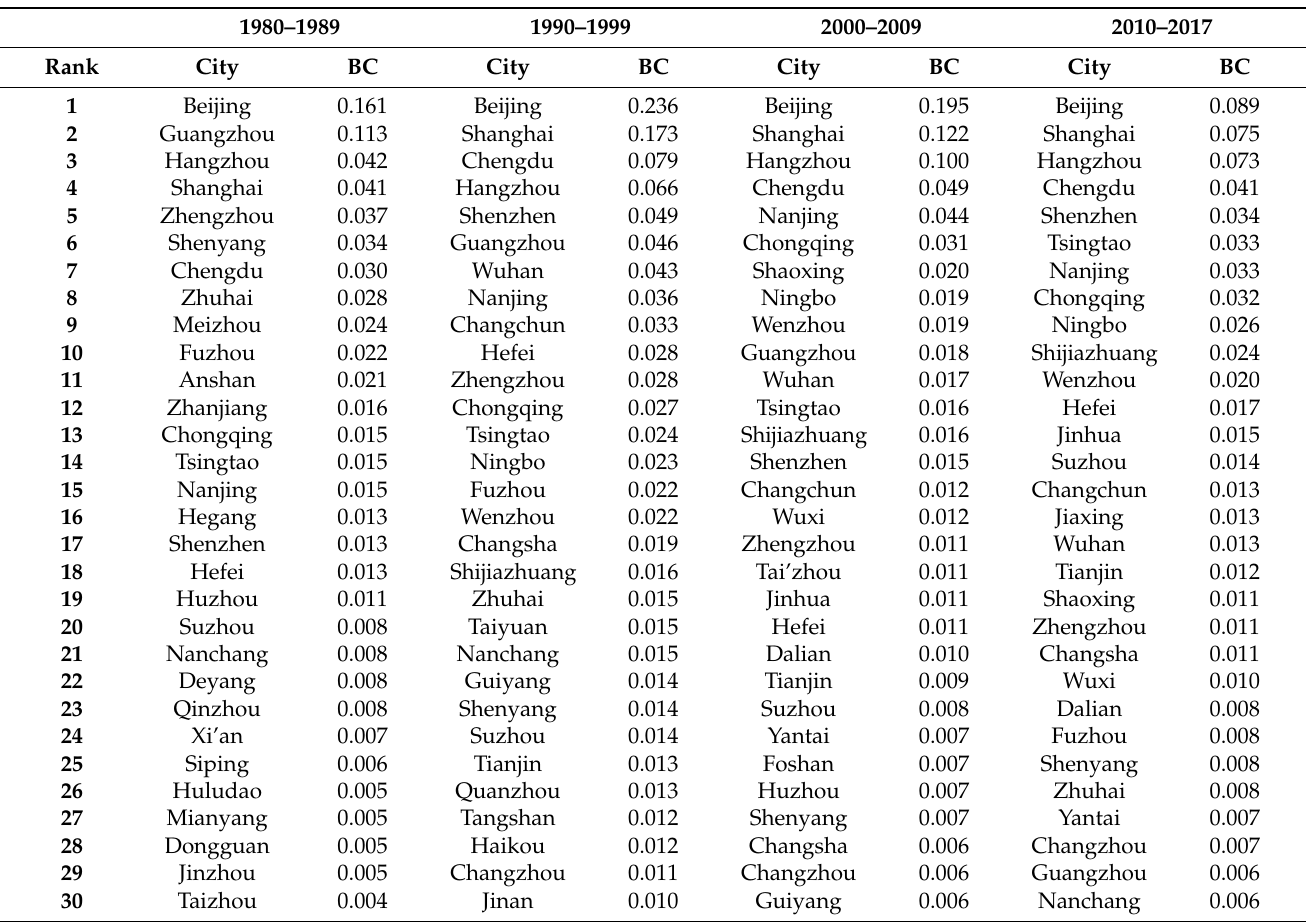
Table 3. Betweenness centrality value of top 30